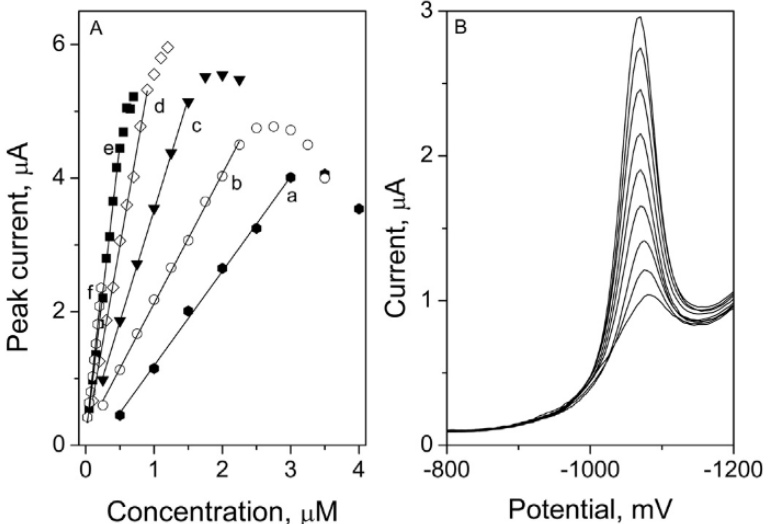
Figure 6. Dexamethasone calibration graphs ( A ) with corresponding voltammograms for the pre- concentration time of 30 s ( B ) measured on refreshable silver-based amalgam film electrode [341].